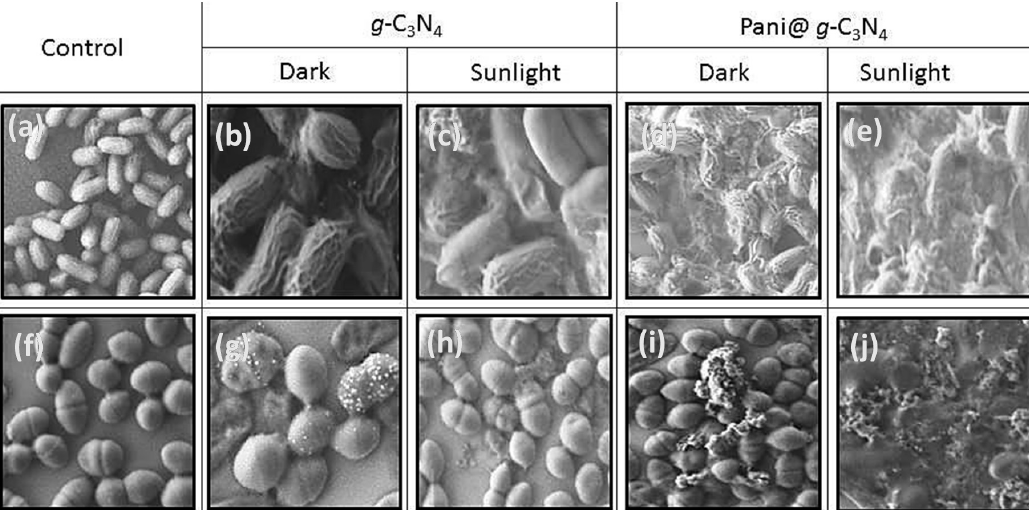
Table 2. Minimum inhibition concentration of compound in absence and presence of sunlight. Minimum Inhibitory Concentration (MIC) Microorganisms g-C 3 N 4 Pani@g-C 3 N 4 Dark Sunlight Dark Sunlight Escherichia coli 75 50 60 30 Streptococcus pneumoniae 100 75 60 25